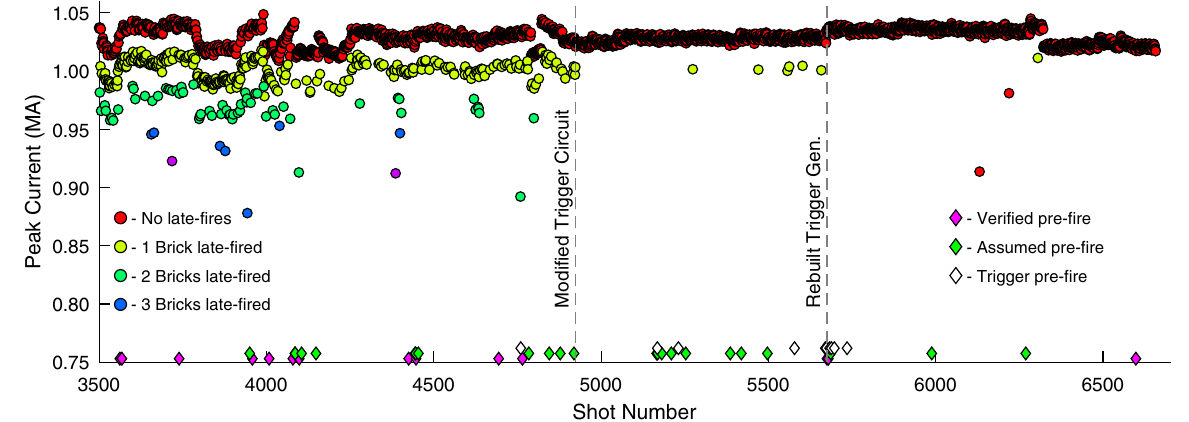
FIG. 10. Peak current and prefire events from the 100-GW LTD cavity from shots 3,500 to 6,657. Step discontinuities in the peak current are a result of day-to-day variations in load water resistivity.